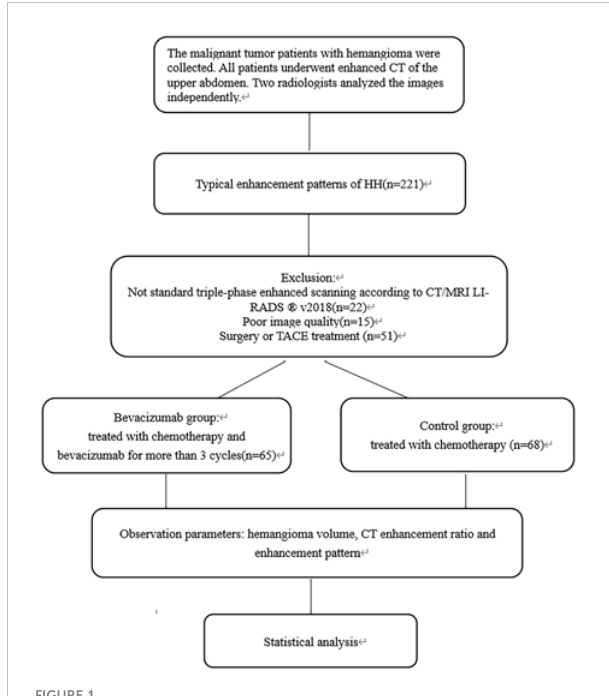
FIGURE 1 Flow chart of Bevacizumab group and control